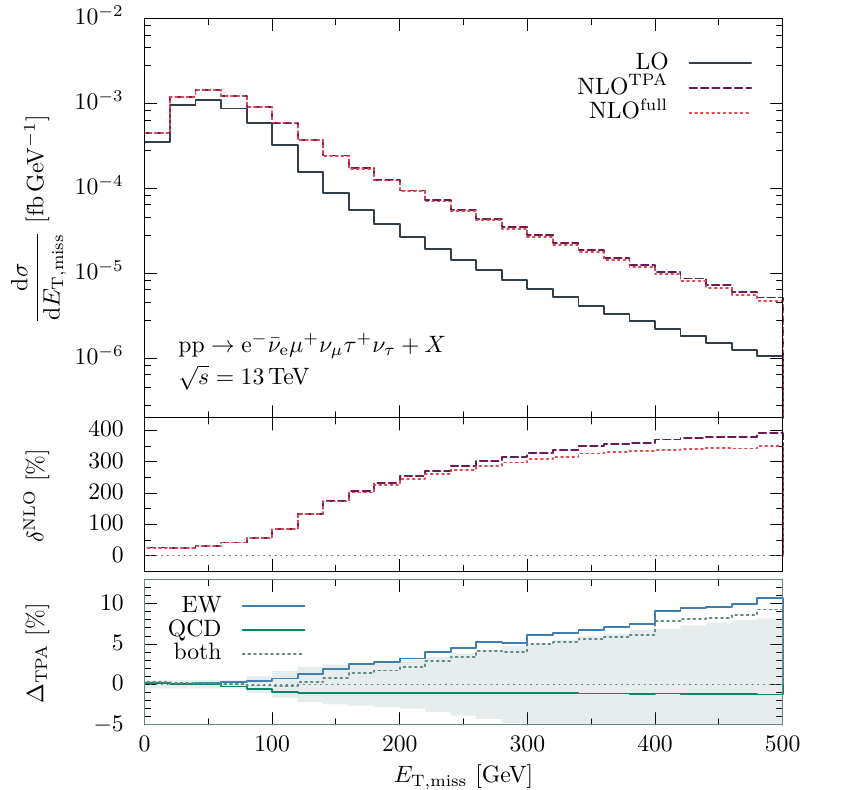
Figure 14. As in (cid:12)gure 12, but for the distribution in the missing transverse momentum E T ; miss